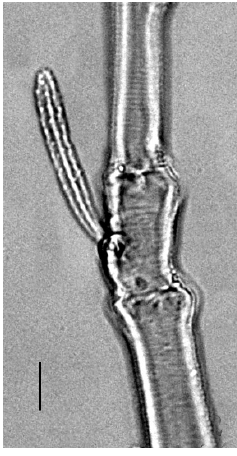
Figure 21. Neophyllobius muscantribii . Female. Genital and anal region. Scale bar: 20 μ m.